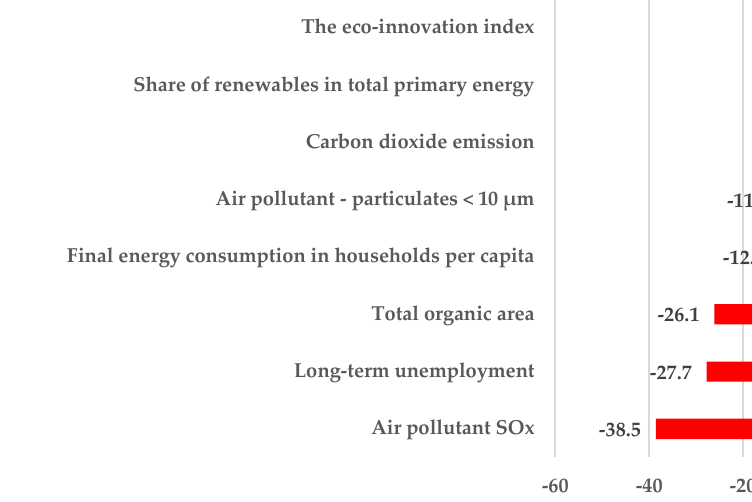
Figure 7. Net change (%) in SDG indicators, Poland, 2010–2018. Own study, based on [31].